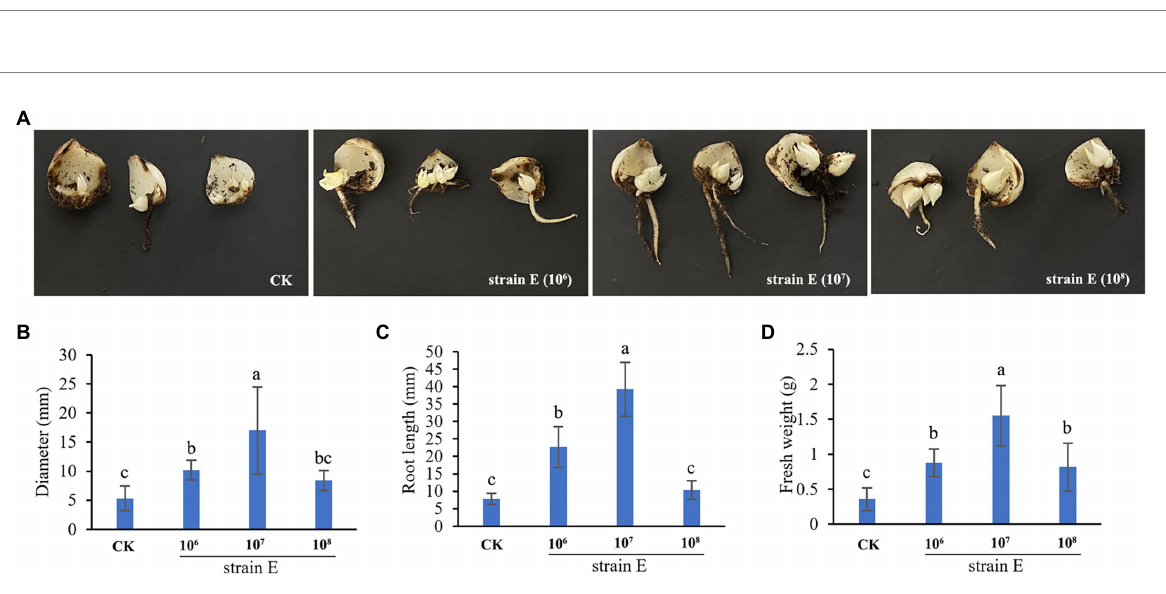
FIGURE 5 Strain E promotes the occurrence of scale bulblets. (A) The occurrence of scale bulblets after treatment with 1 × 10 6 CFU/ml, 1 × 10 7 CFU/ml, and 1 × 10 8 CFU/ml bacterial suspension. (B) Diameter of scale bulblets. (C) Root length of scale bulblets. (D) Fresh weight of scale bulblets. Sterile water was used as a control. Bars labeled with different letters are significantly different ( p < 0.05) according to Duncan’s multiple range